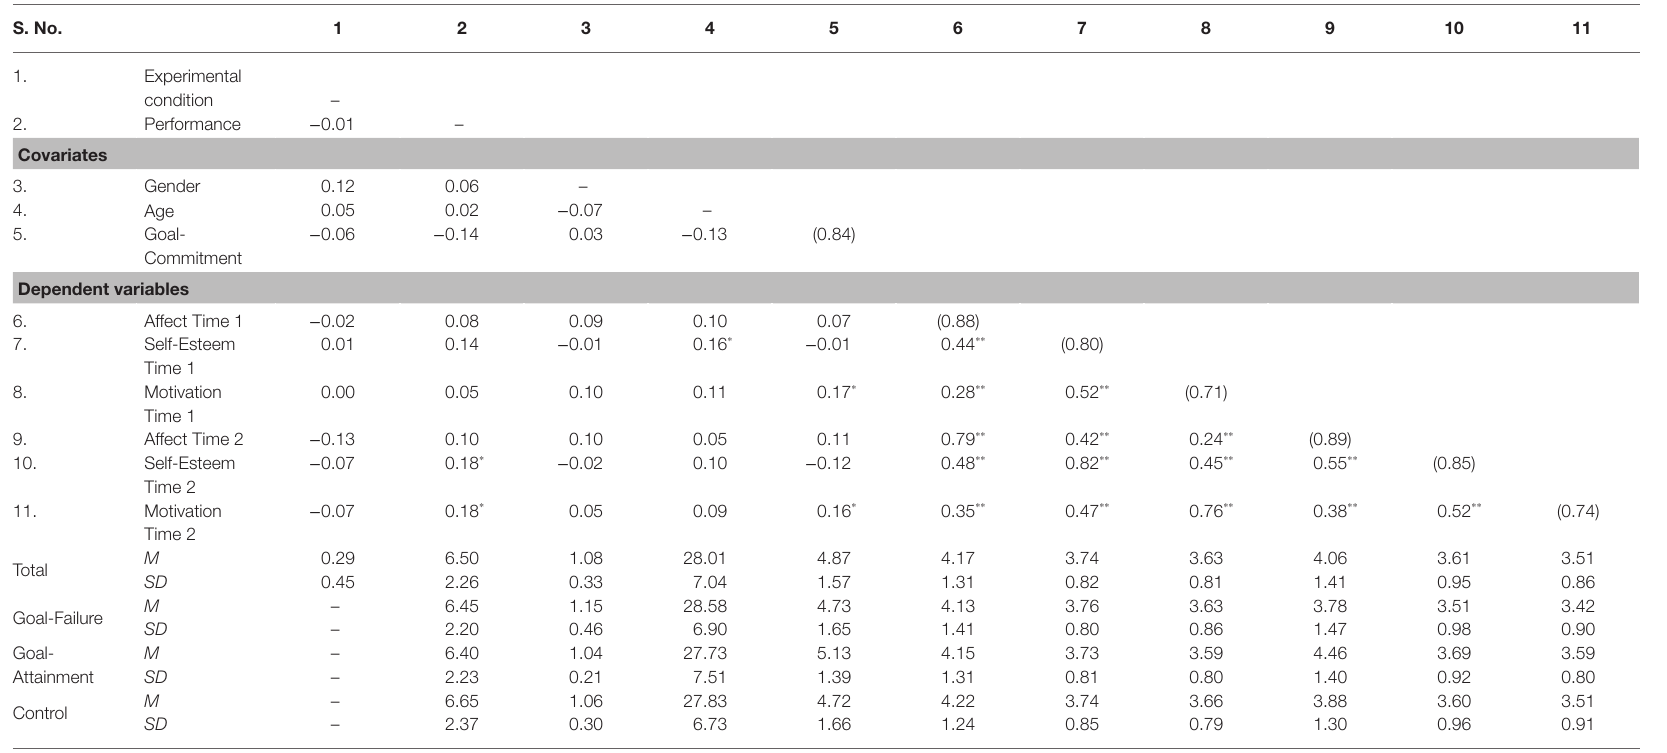
TABLE 3 | Descriptive statistics and bivariate correlations Study